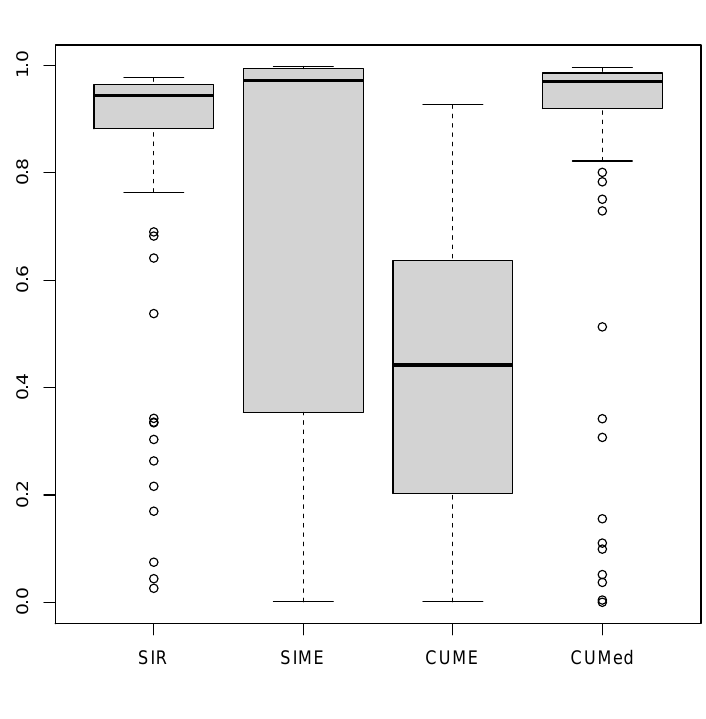
Figure 1. Performance of 100 repetitions of the experiment of the introduction of outliers in the concrete strength